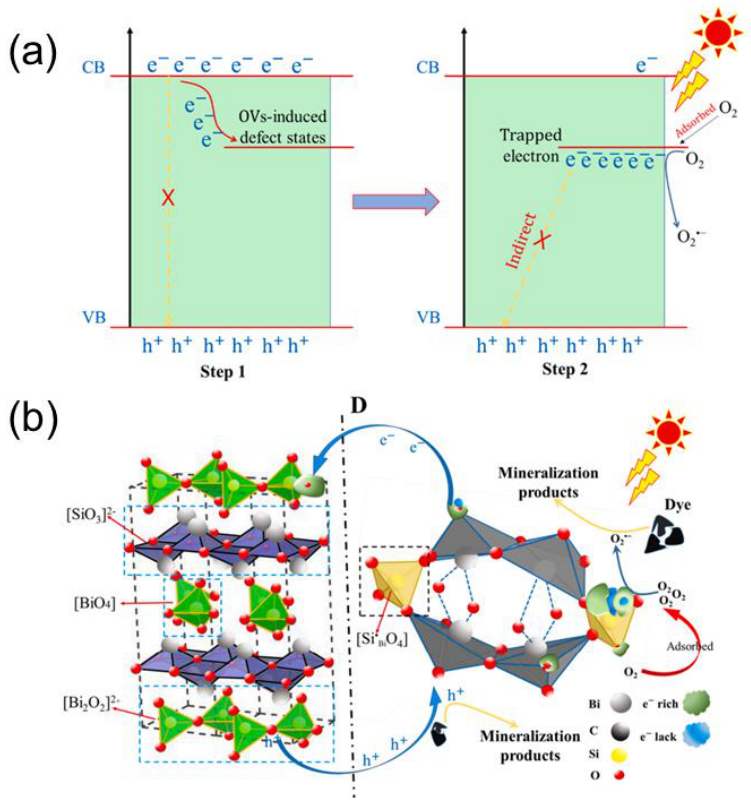
Figure 15. ( a ) Schematic diagram for the enhanced photogenerated electron transfer processes induced by OVs. ( b ) Schematic diagram for the migration and separation of electron-hole pairs and the photocatalytic process of the Bi 2 SiO 5 /Bi 12 SiO 20 heterojunction photocatalyst: Crystal structure of Bi 2 SiO 5 ( left ) (Si • BiO 4 ) tetrahedron and (BiO 5 ) pyramids in Bi 12 SiO 20 crystal structure ( right ). Reproduced with permission from [159]. Copyright 2022 Elsevier.